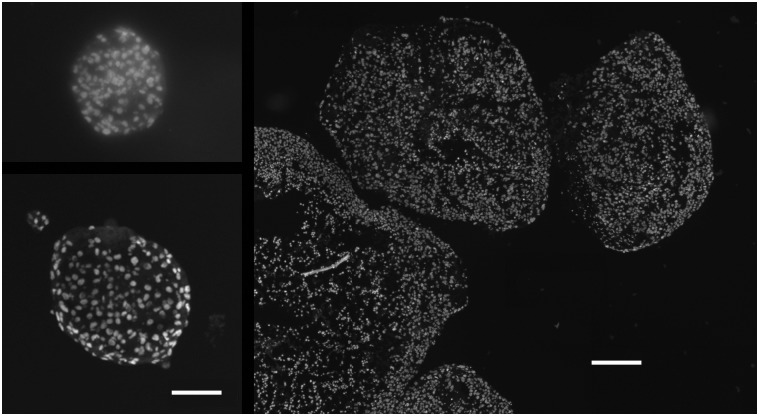
Cross sections of various types of SQ20B spheroid.Spheroids from tumor-cells only were very small (upper left), those from mixed-cells (with MRC5) somewhat larger (lower left) and from tumor-fragments much larger still (right; all nuclei stained with Hoechst 33342). The larger TF spheroids developed central necrosis (absent or pyknotic nuclei) with a relatively thin rim of viable cells. The scale bars represent 100 μm for the two left panels and 250 μm for the right panel.